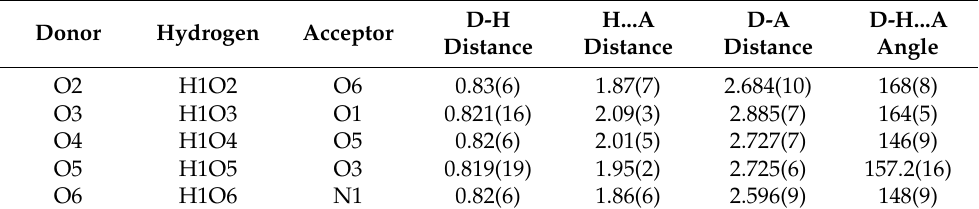
Table 3. All hydrogen bond types.